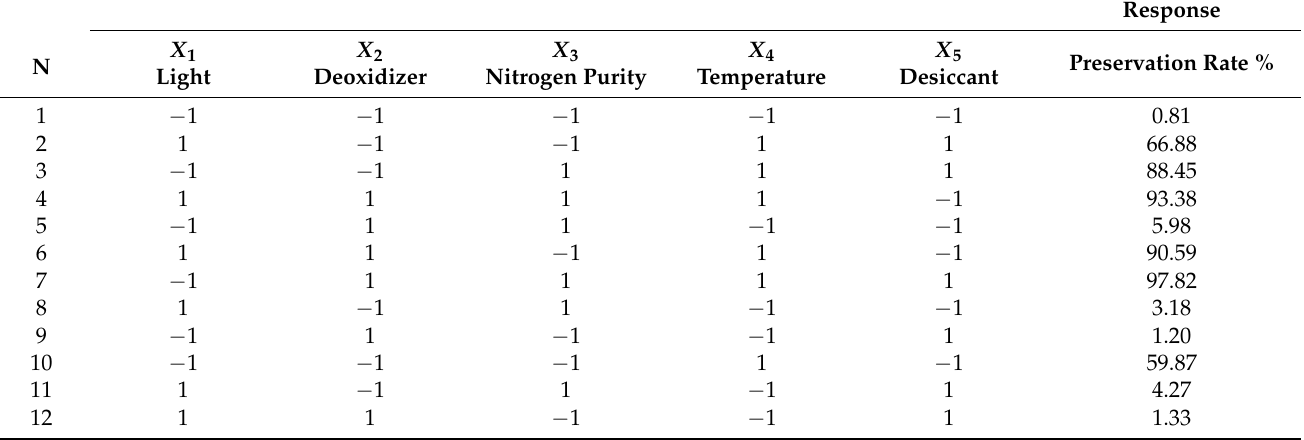
Table 1. Results of Plackett–Burman experiment.